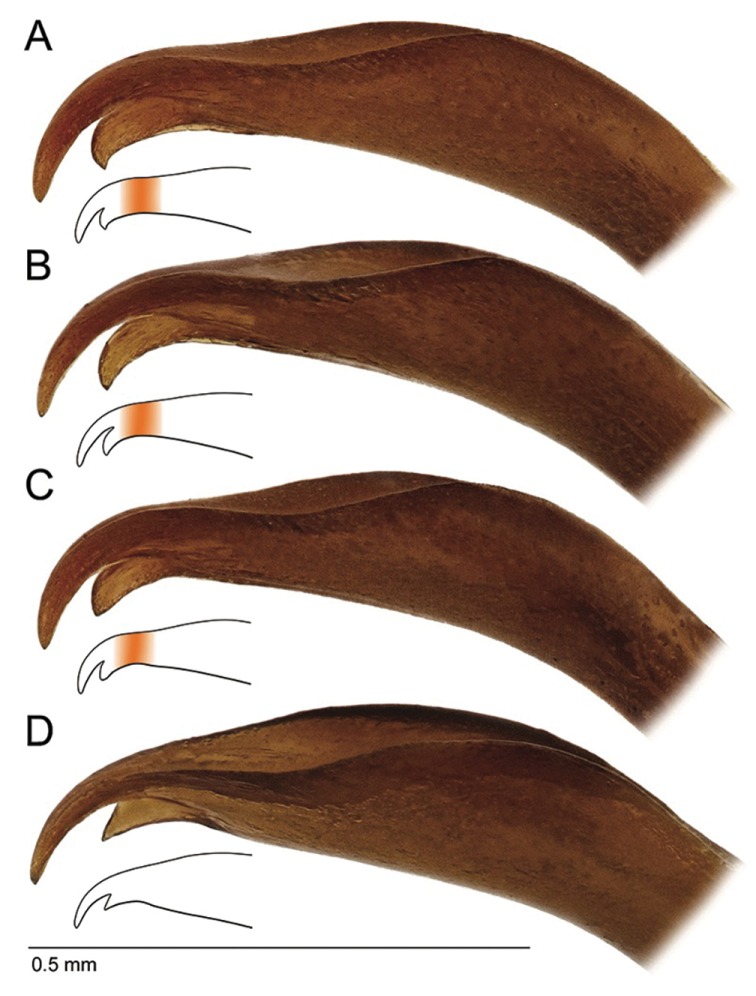
Agabus spp., lateral view of tip of aedeagus A–CA.
raffrayi, different specimens showing the variation in shape of the subapical tooth DA.
austellus sp. nov. Note the prolonged section between subapical broadening and base of apical and subapical teeth in A.
raffrayi (indicated with orange in the smaller outline illustrations).